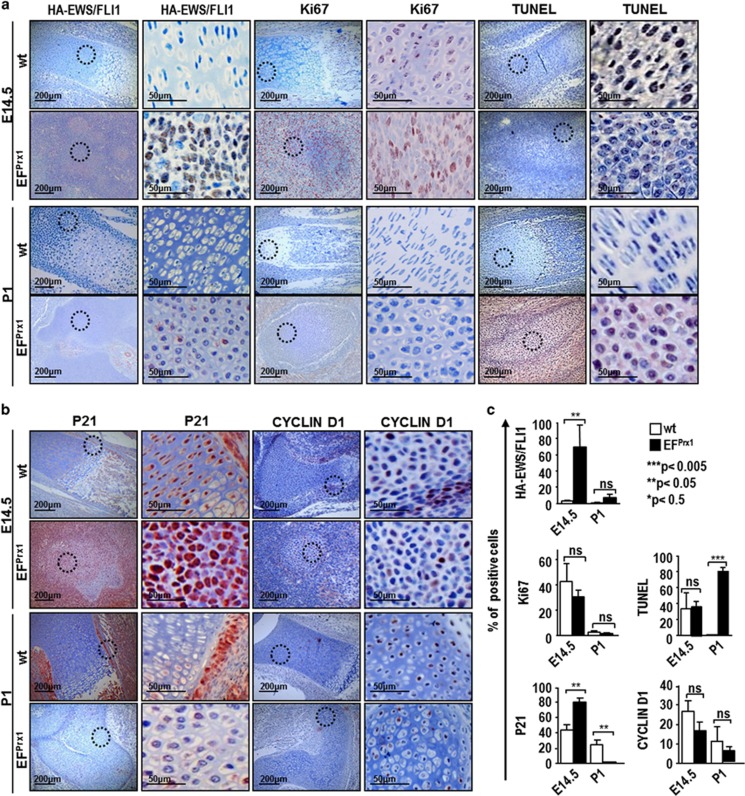
EF expression induces apoptosis and leads to diminished cell cycle progression. (a) HA-tag staining was performed to detect the EF translocation product. The rate of proliferation was comparable to wt based on Ki67 proliferation marker staining. TUNEL staining displayed highly elevated apoptosis at P1. (b) P21 (CDKN1A) protein level was upregulated. Prominent nuclear staining of P21 at E14.5, decreased at E16.5 and P1. cyclin D1 expression was decreased during development till P1. Black circles indicating the magnified region showing in the next column. (c) Quantification of IHC from part A and B. At least three different independent embryos of wt or mutant for every single staining and for each time point were analyzed. Experimental staining results were evaluated using (ANOVA) one-way analysis of variance. Insets in separate panel highlight cellular details. *P<0.5, **P<0.05 and ***P<0.005